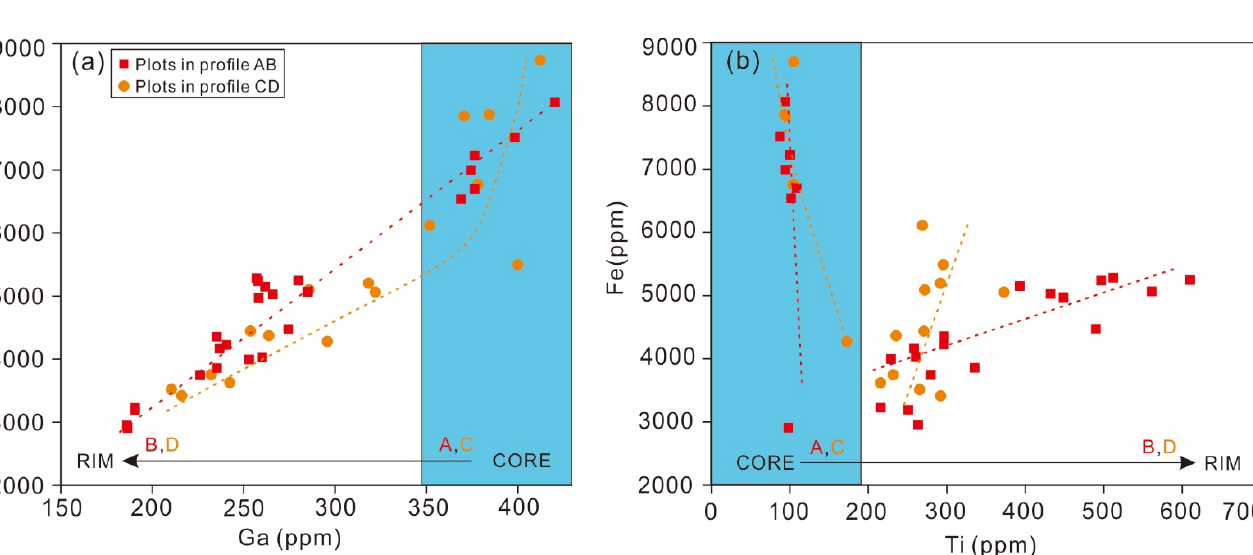
Figure 9. Plots of ( a ) Ga ‐ Fe and ( b ) Ti ‐ Fe for Penglai